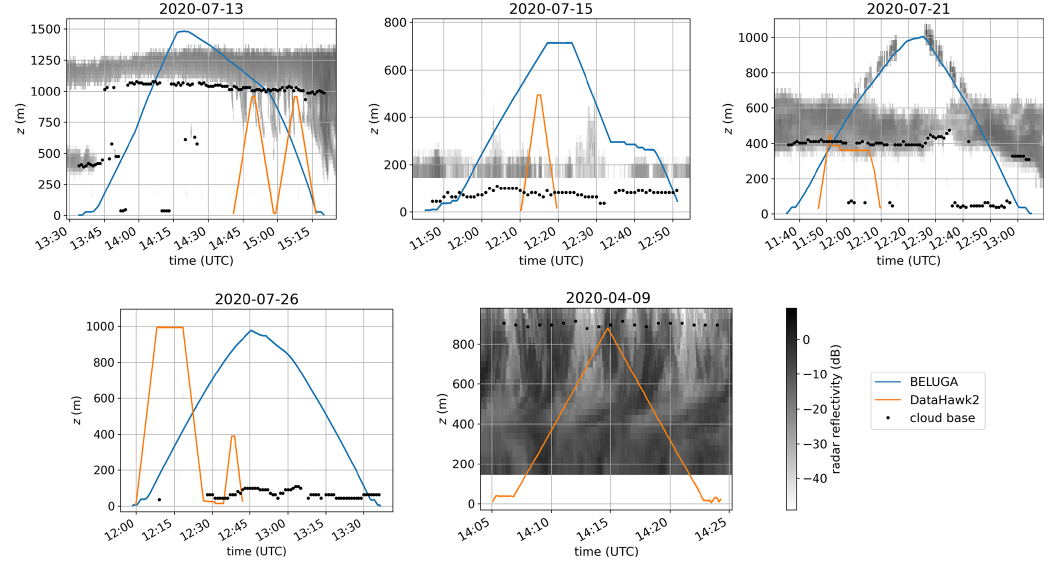
Figure 1. Time–height profiles of DH2 and BELUGA flights for days presented in this paper. Days in July 2020 include the cases in which both platforms were operated simultaneously. Cloud base is from the RV Polarstern ceilometer (Schmithüsen, 2021). The gray shading shows radar reflectivity (Johnson et al., 2021). Note that the BELUGA balloon was observed by the radar during the case on 21 July 2020.